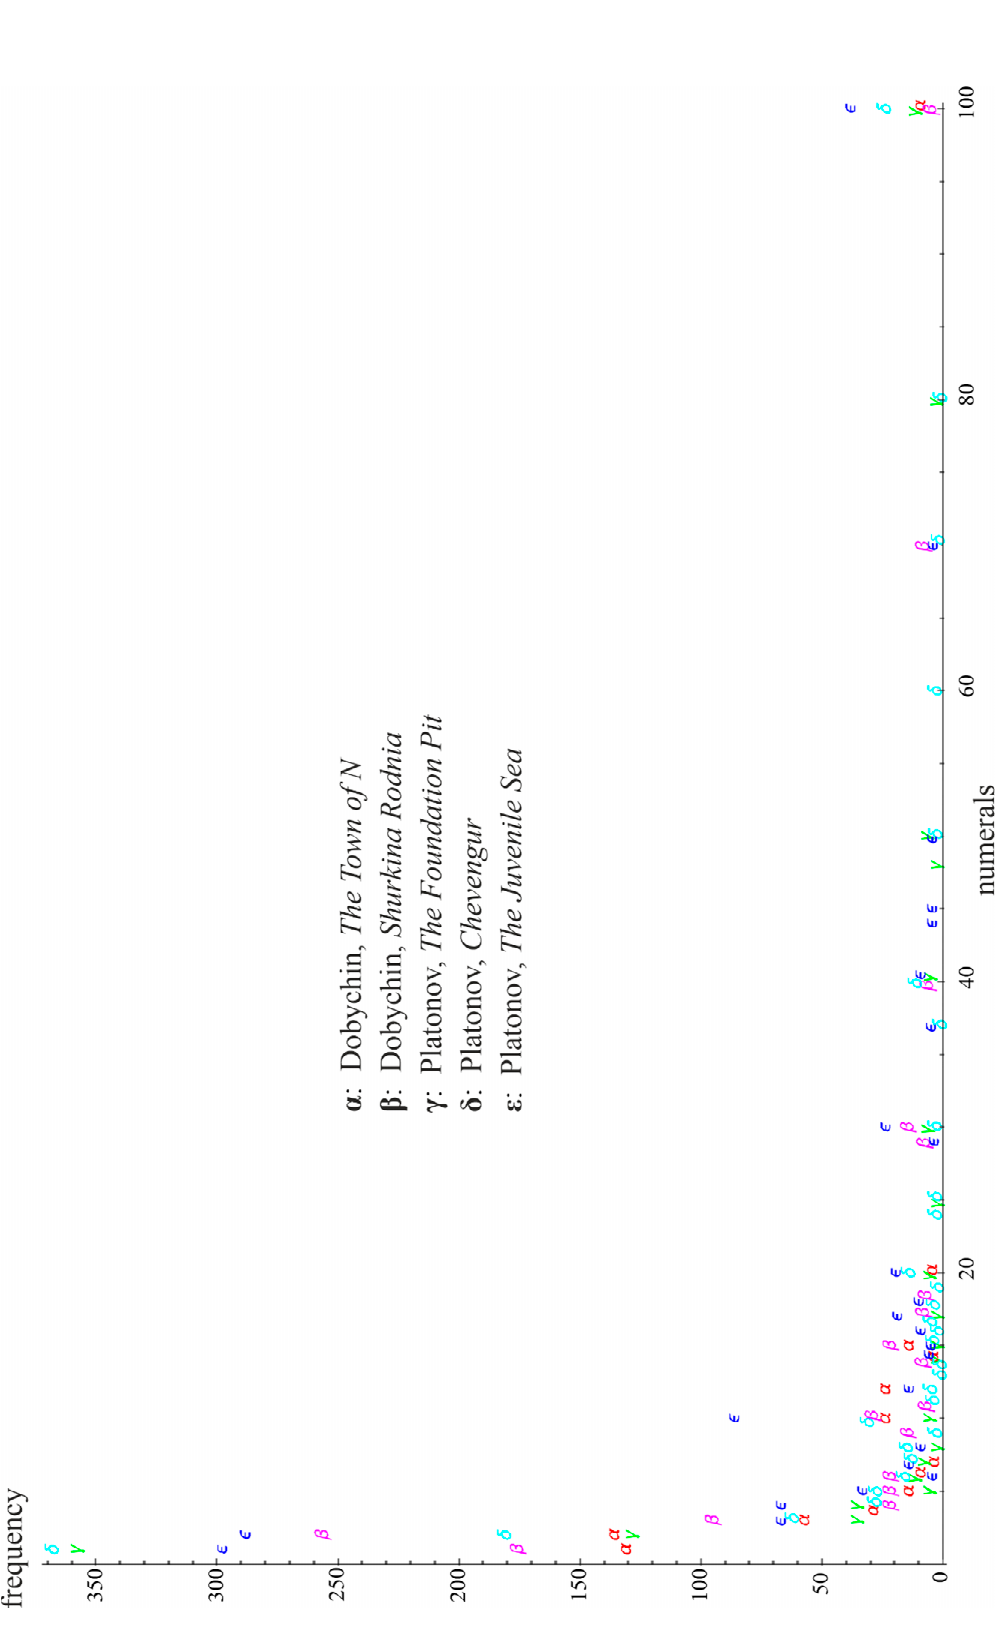
Figure 12. Absolute frequencies of numerals from [0, 100] range in Dobychin’s and Platonov’s texts.